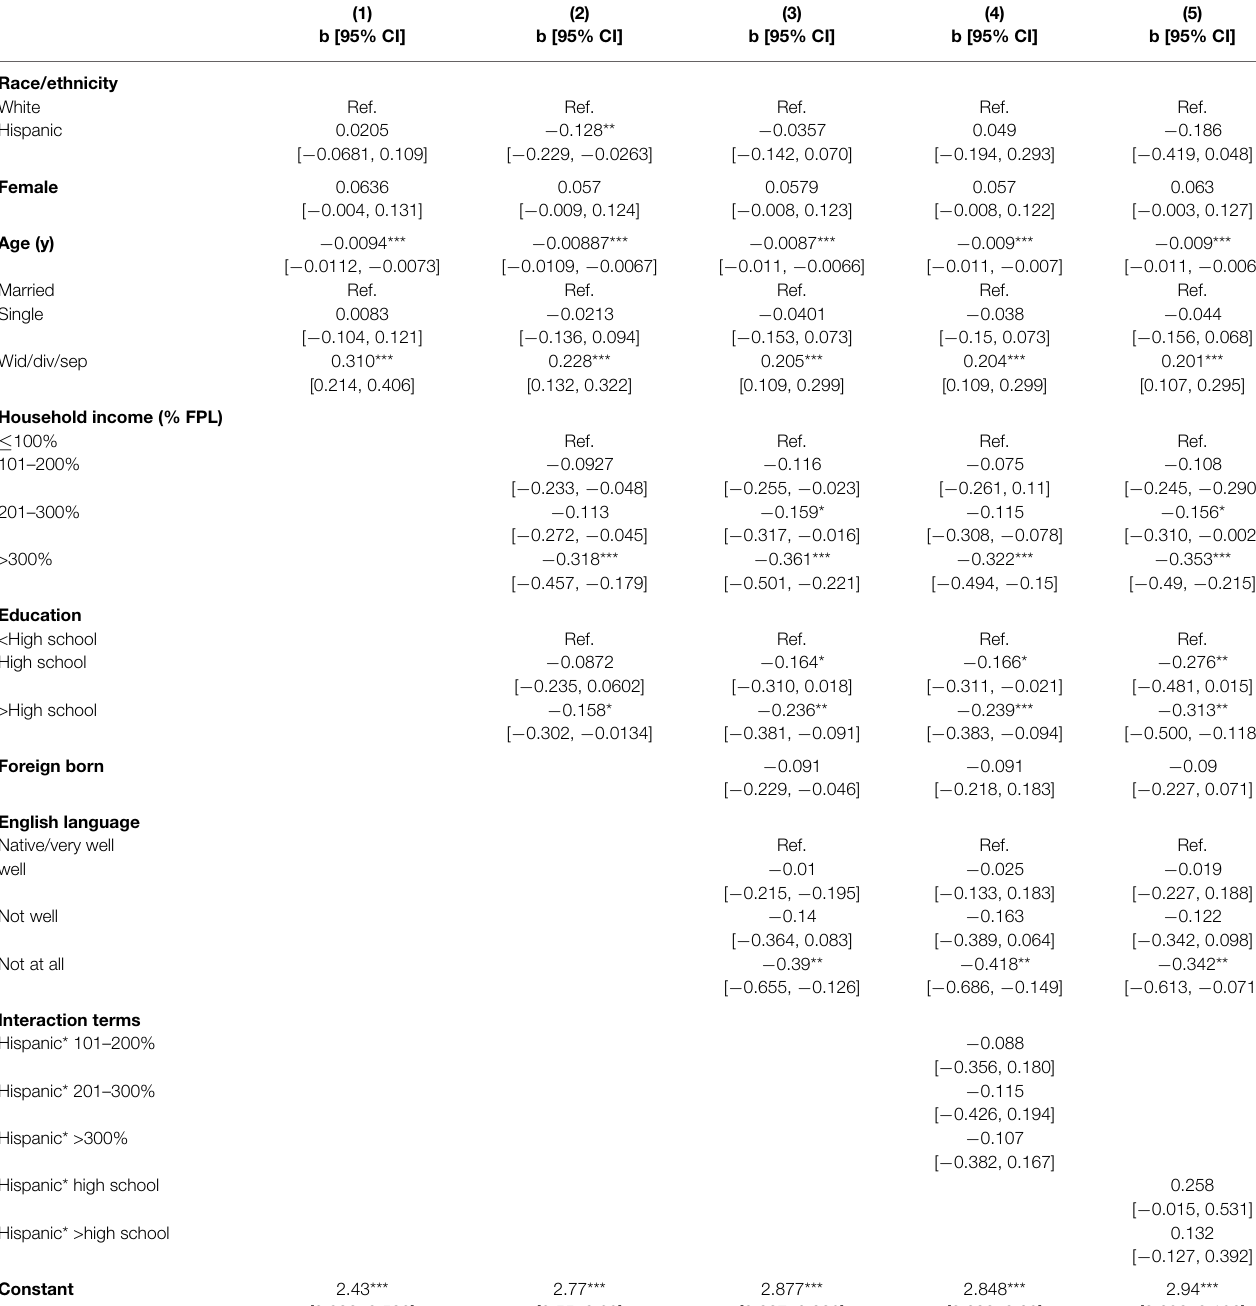
TABLE 3 | Linear regression models predicting the square root of the Kessler K6 score of Hispanic and White adults in the 2010 AHS ( n = 6,070)